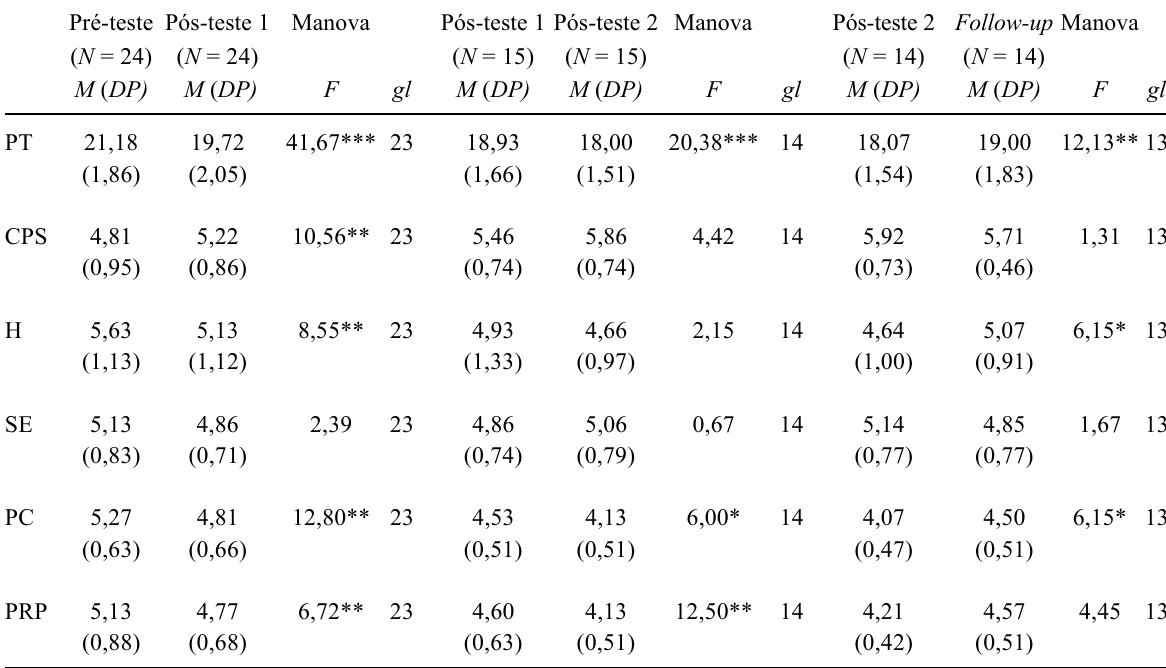
Pré-teste Pós-teste 1 Manova Pós-teste 1 Pós-teste 2 Manova Pós-teste 2 Follow-up